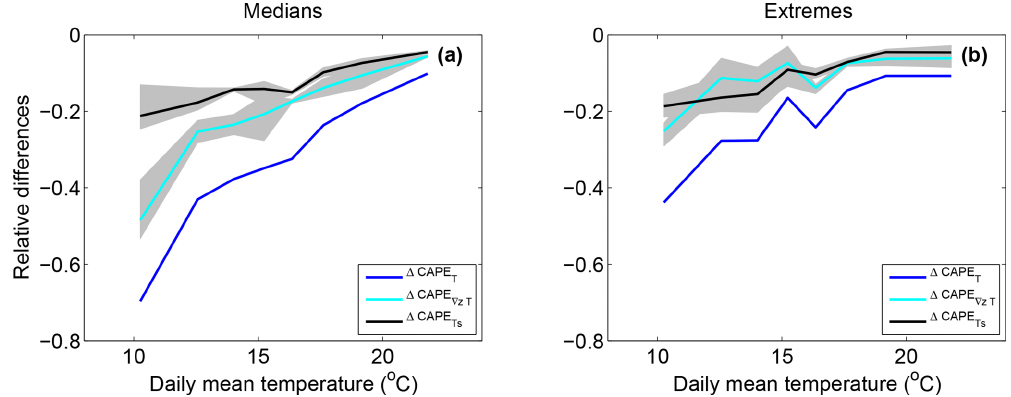
Figure 12. Temperature vertical profile contribution to the change in CAPE between the LR MAX and the LR MIN simulation for median (a) and extreme (b) convective precipitation events (blue, (cid:49) CAPE T ). The surface temperature contribution ( (cid:49) CAPE T and the temperature vertical gradient contribution ( (cid:49) CAPE ∇